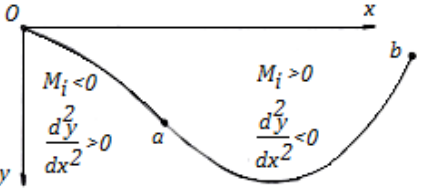
Figure 2. Establishing the sign of the di ff erential equation of the average deformed fi ber.